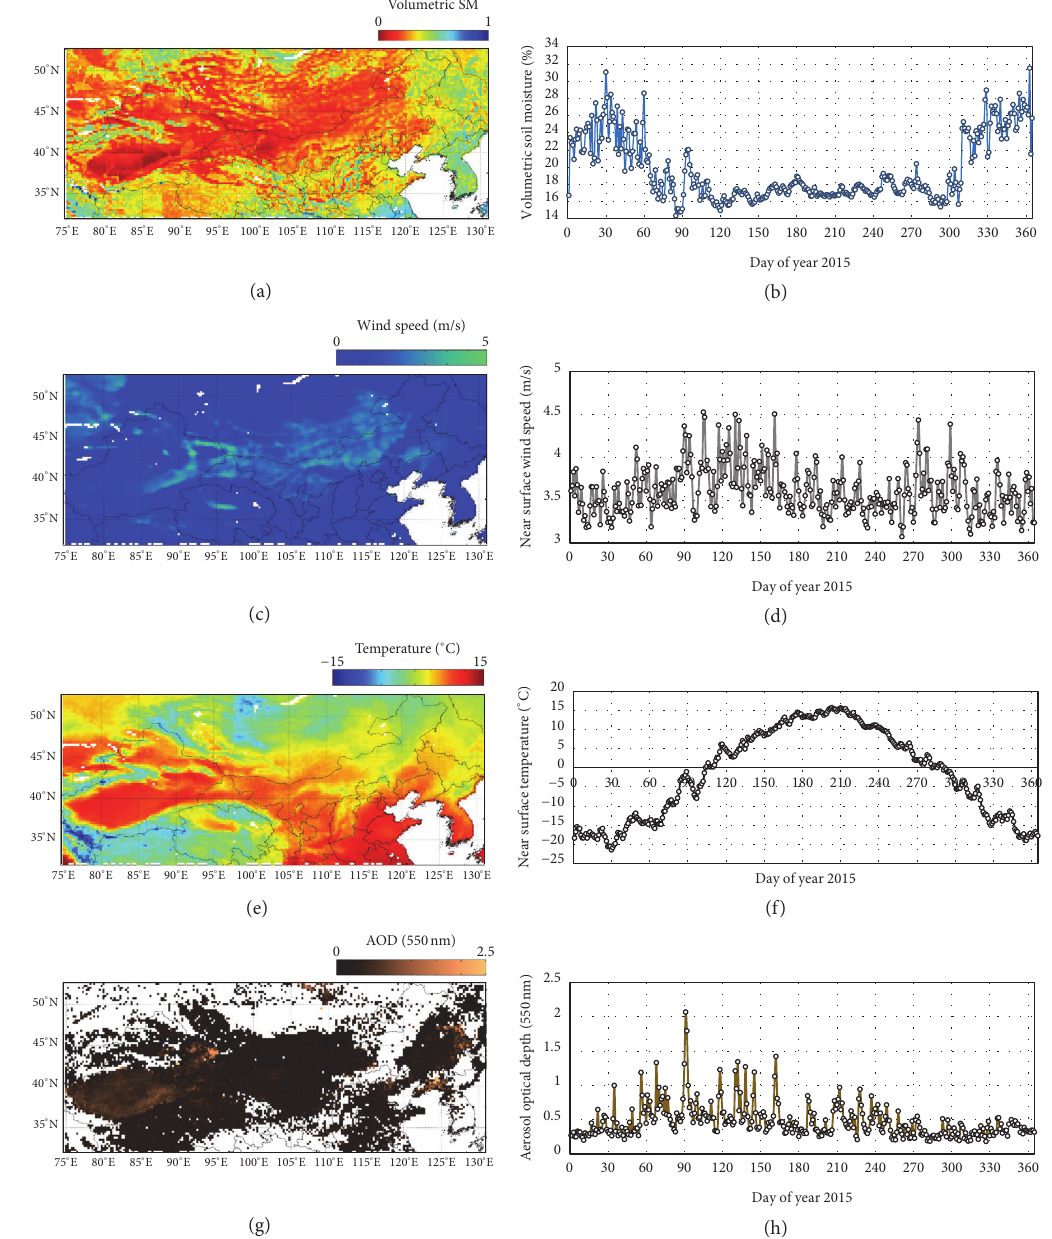
Figure 4: (a) The map of GLDAS volumetric soil moisture contents (%). (b) The time series for the average value of volumetric soil moisture from the GLDAS for the desert regions. (c) The map of GLDAS near-surface wind speed (m/s). (d) The time series for the average value of the GLADS near-surface wind speed for the desert regions. (e) The map of GLDAS near-surface temperature ( ∘ C). (f) The time series for the average value of near-surface temperature for the desert regions. (g) The map of MODIS-based aerosol optical depth (AOD). (h) The time series for the average value of AOD for the desert regions. All GLDAS datasets are based on SMOS local overpass time.